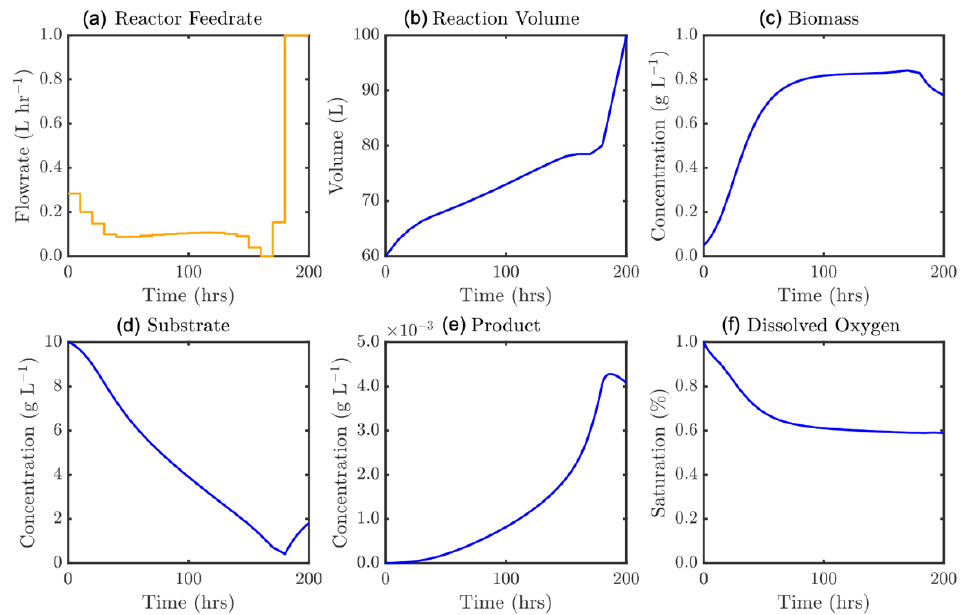
Figure 12. Optimal feedrate profile ( a ) and corresponding model states, ε = 200 h: ( b ) culture volume, and concentrations of ( c ) biomass, ( d ) substrate, ( e ) product, and ( f ) dissolved oxygen.